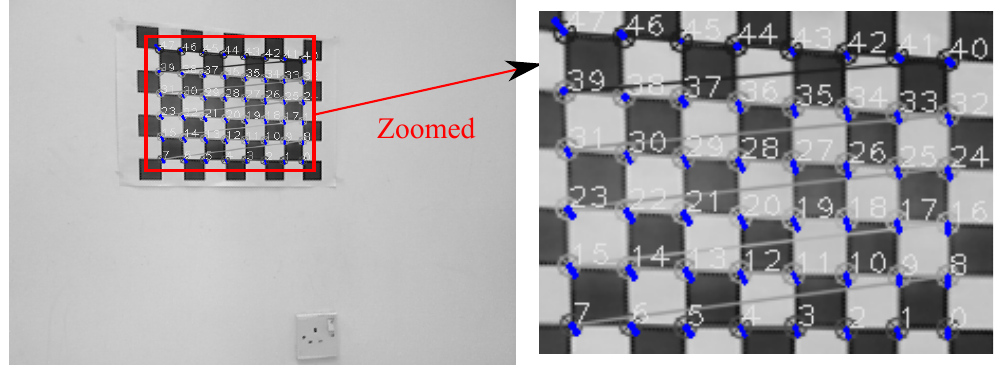
Figure 8. Configuration 3: Reprojection error based on the estimated X and Z matrices. Blue lines indicate the amount of the reprojection error (original image resolution 640 ×